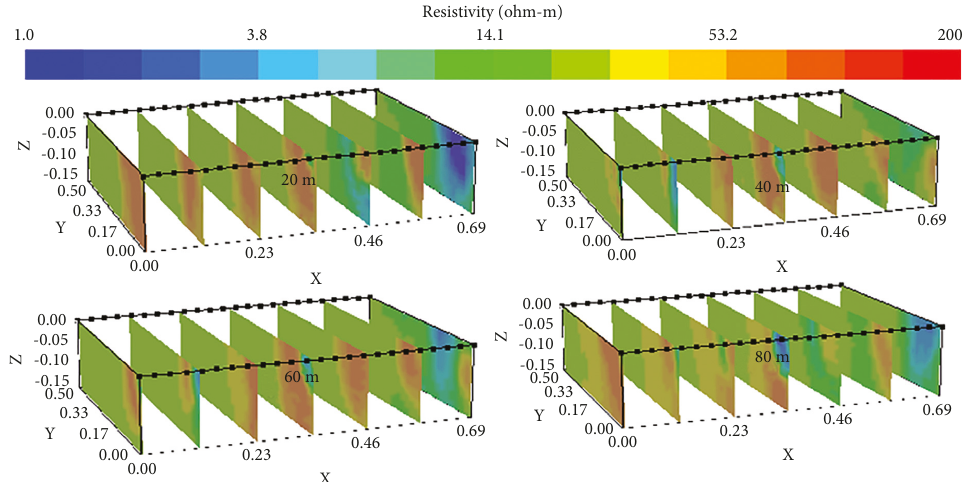
Figure 11: The resistivity section diagram along the x -axis direction at 15 cm above the coal seam.